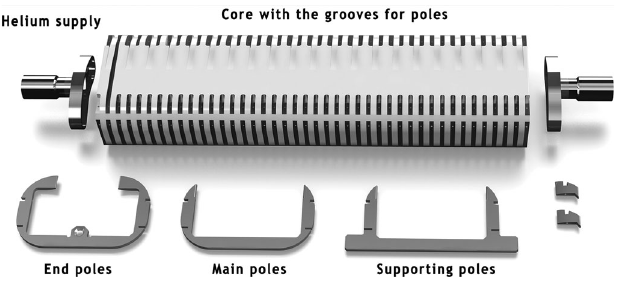
FIG. 2. Main parts of the SCU0 magnetic